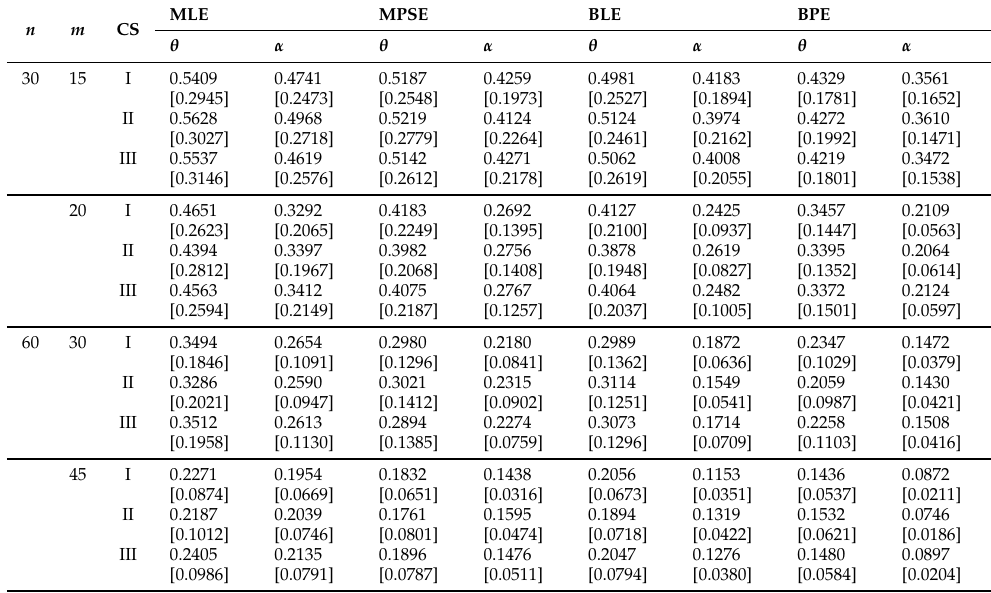
Table 3. The ABs and MSEs (within bracket) for the model parameters at ( α , θ ) = ( 2.1,1.3 ) .